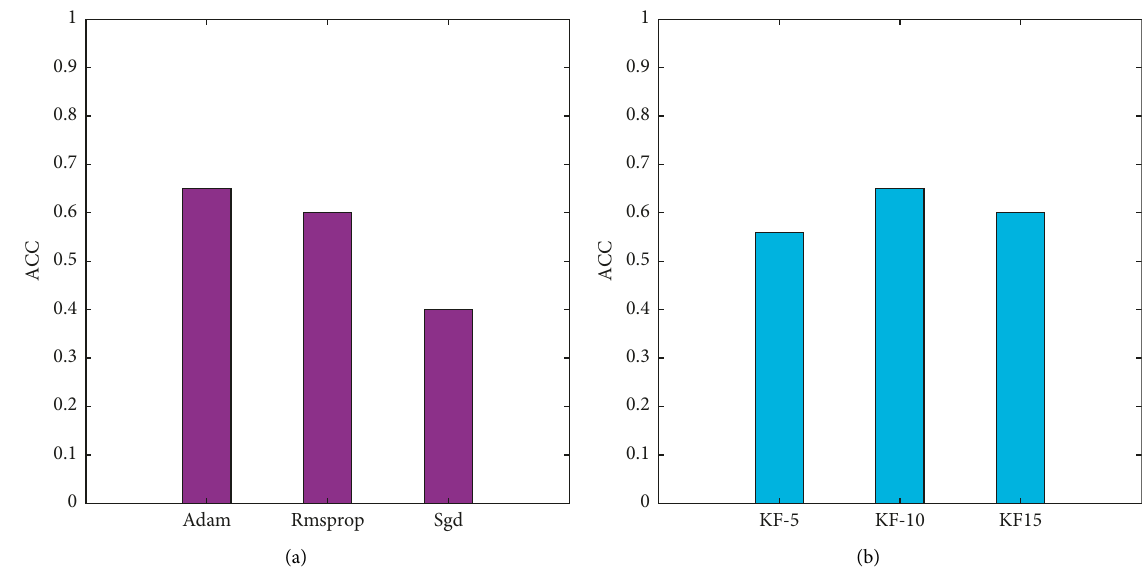
Figure 6: Accuracy under different optimizers and K_fold settings. Table 6: Recognition accuracy of different models on each dataset. Model/dataset